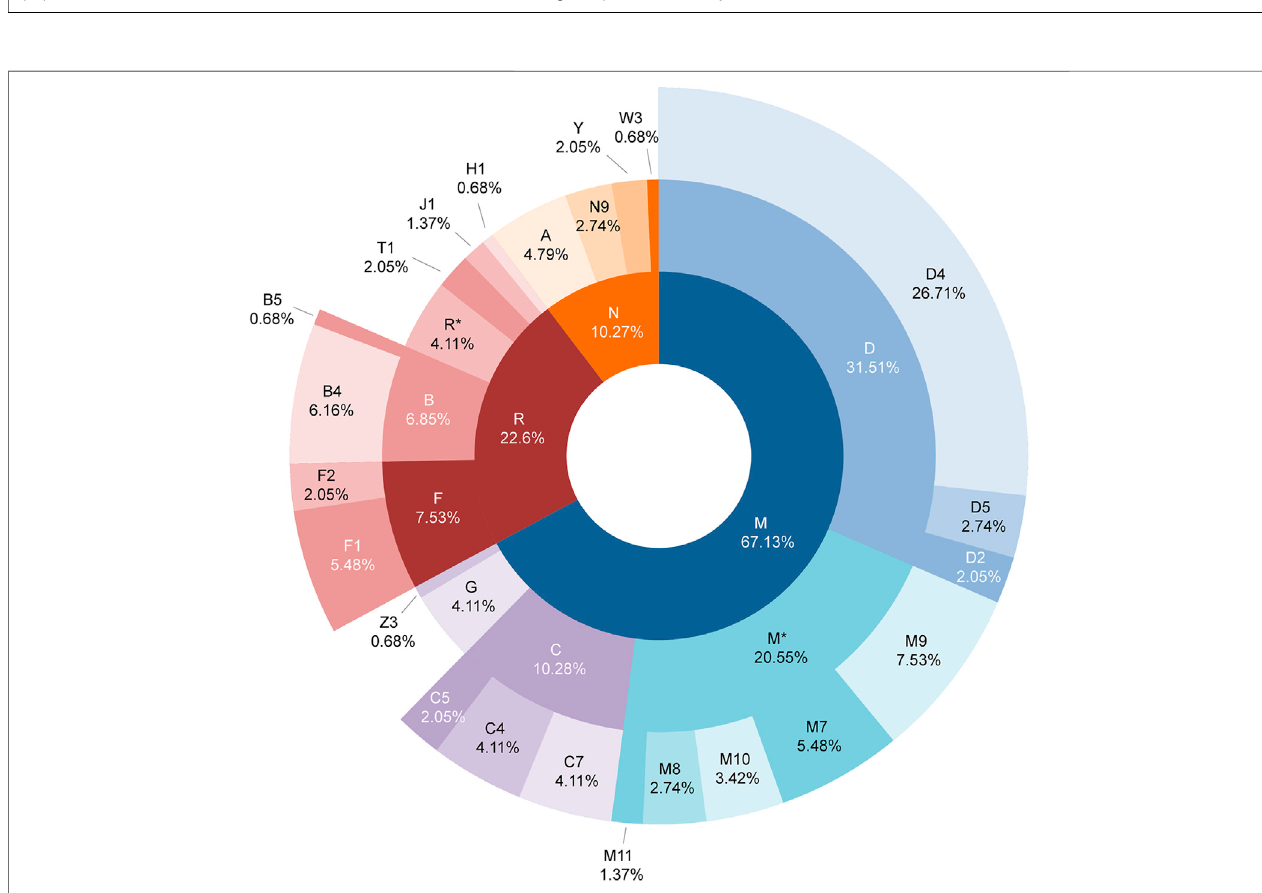
FIGURE 4 | Distribution of mitochondrial haplogroups in the Daur ethnic group. The macro haplogroups M, N, and R displayed in the innermost circle are representedbydifferentcolors.Thecircleinthemiddlerepresentsthedistribution andproportionofeachhaplogroupbelongingtomacrohaplogroupsM,N,andR.The outermost circle shows the distribution and proportion of sub-haplogroups in more detail.